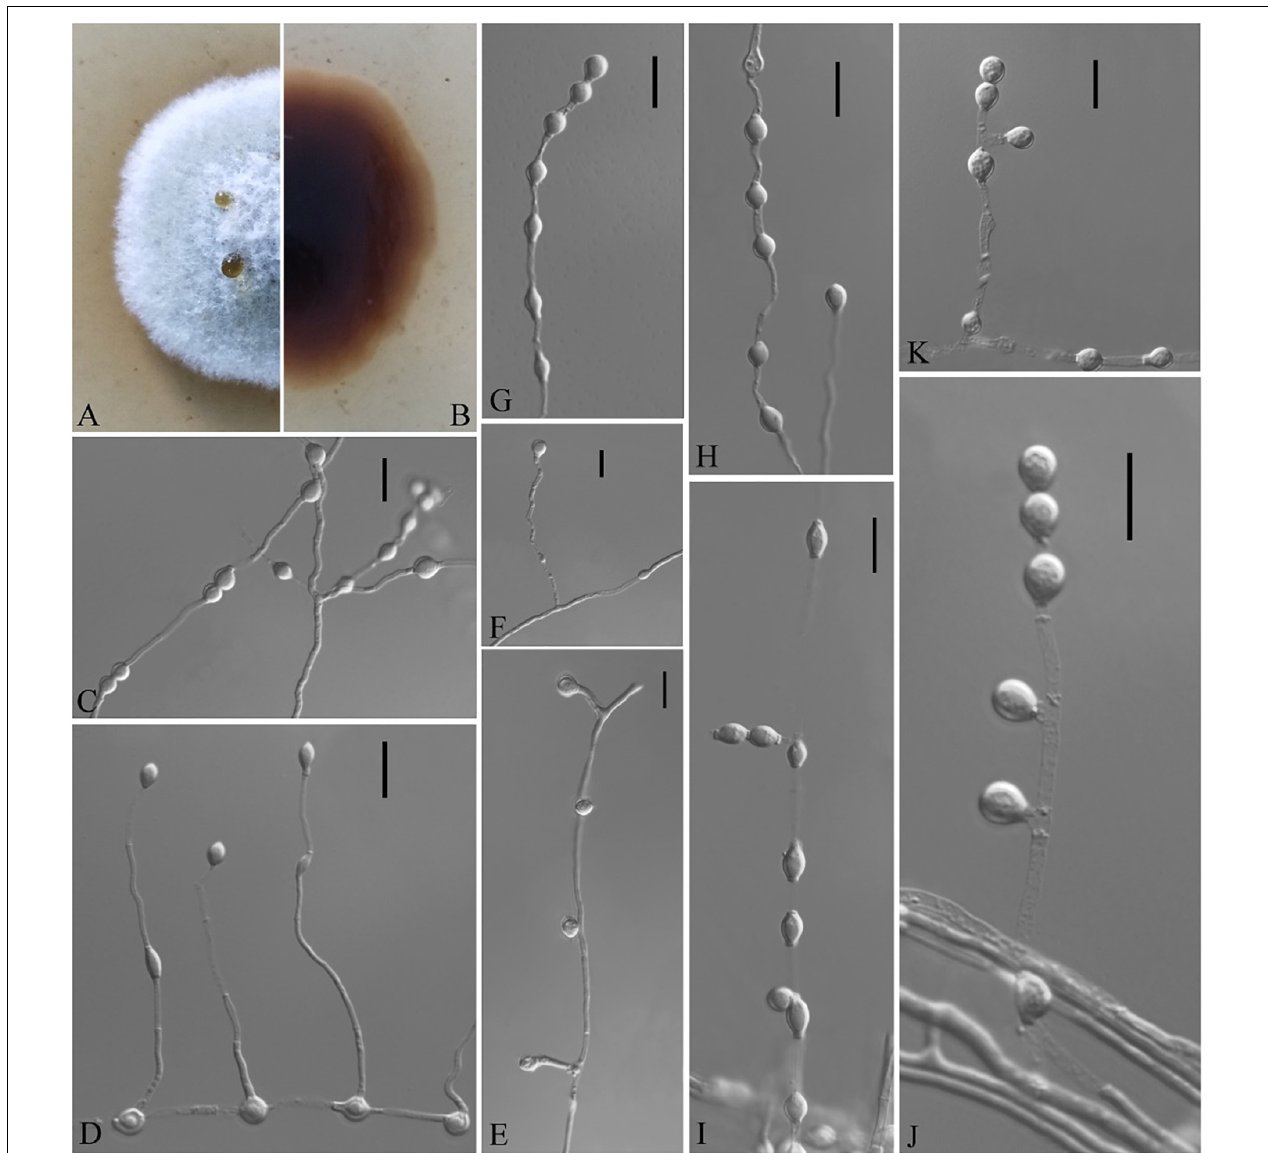
FIGURE 7 | Solomyces sinensis (from ex-holotype CGMCC 3.18498). (A,B) The front and reverse of a S. sinensis colony on PDA after 14 days at 25 ◦ C. (C–K) Conidiophores and conidia. Scale bars = 10 µ